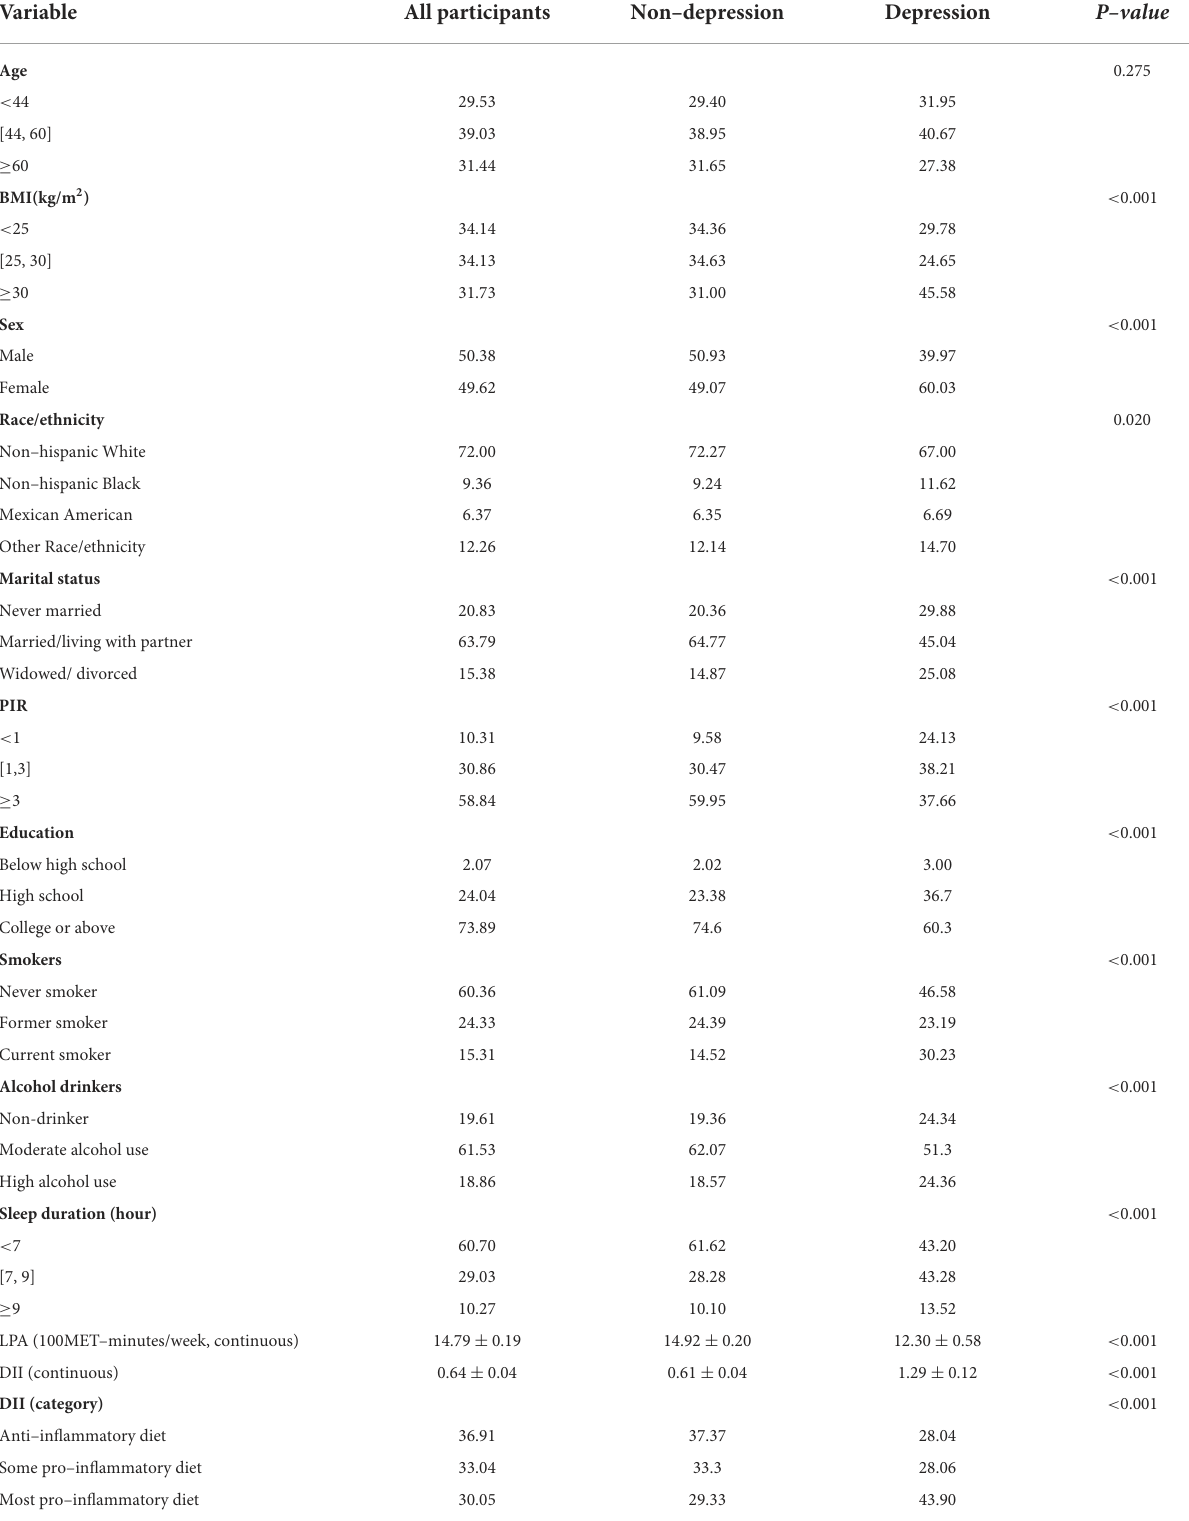
TABLE 1 Weighted characteristics of study populations in the NHANES (2007 – 2018) by depression. Variable All participants Non–depression